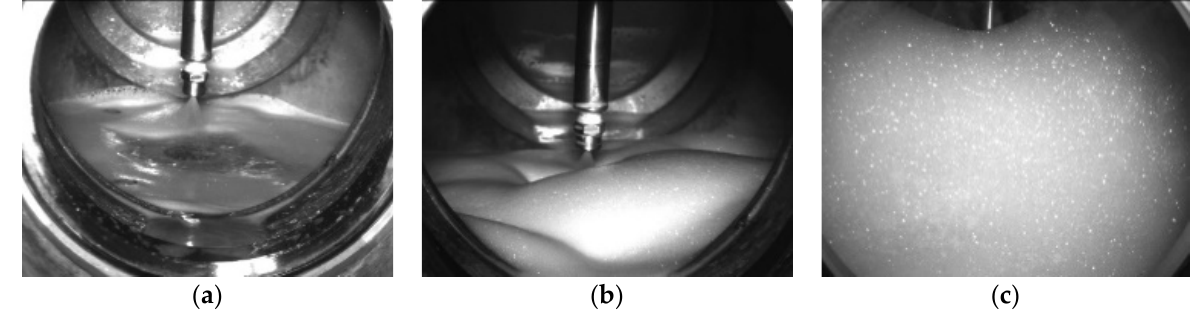
Figure 24. Visualization images of the foam inside the chamber of the ethanol–water mixture at different CTAB concentrations: ( a ) 20 ppm; ( b ) 40 ppm; ( c ) 60 ppm.